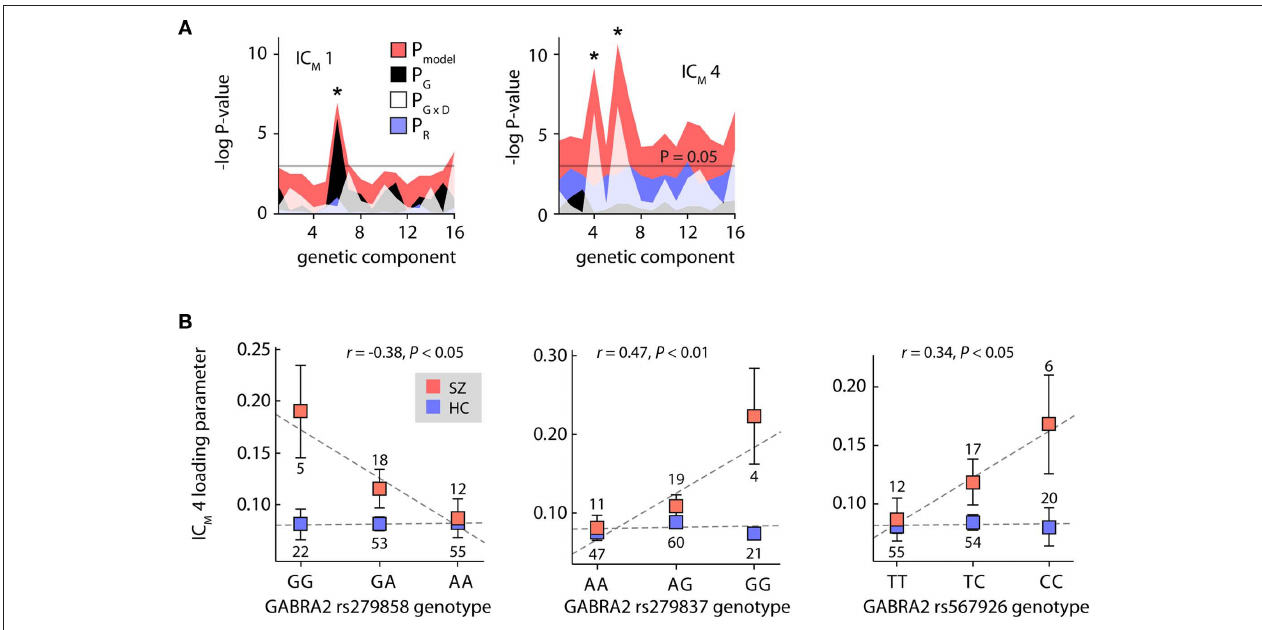
Bonferroni correction for 32 tests. Examination of the individual beta weights FiGuRE A2 | Genetic contributions to cross-frequency modulation. (A) 1 (Left, black; t = 3.05 revealed a main effect of genetic component 6 on IC Genetic component association results, including race in the regression model. M 165 , P < 0.005). Associations with IC 4 were both due to interactions between the Plot of the negative natural logarithm of the P -values for the regression models M genetic components and the diagnosis (Right, white; t = 3.30 P < 0.005 and between each of the 16 genetic components and cfM components 1 (Left) and 4 165 , t = 3.18 P < 0.005 for IC 6 and IC 4, respectively). No significant associations (Right). The pink shaded region indicates the uncorrected P -values for the full 165 , G G with race were found. (B) Plots of modulation component loading parameters as a model, while the black, white, and blue regions show the P -values for the genetic, function of GABRA2 genotype. Data is stratified by SZ (red) and HC (blue) to genetic × diagnosis, and race terms, respectively. Asterisks denote significant highlight group × diagnosis interactions. Error bars denote ± 1 SEM. Dashed line models between (1) IC 1 and IC 6 (Left, pink; F = 4.88, P < 0.001), (2) IC 4 M G 4,165 M shows the least-squares linear fit to the data. The number of individuals with each and IC 6 (Right, pink; F = 7.18, P < 0.00005), and (3) IC 4 and IC 4 (Right, G 4,165 M G genotype is indicated adjacent to the pink; F = 6.23, P < 0.0005). Associations were all significant at P < 0.05 after 4,165